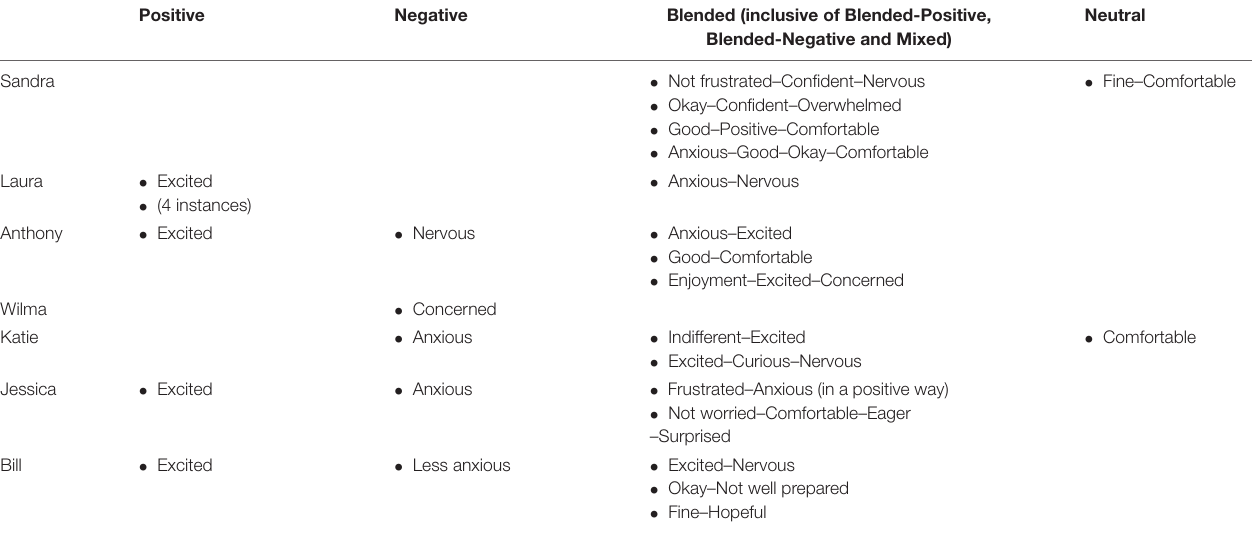
TABLE 3 | Categorization of teachers’ emotions by type from the pre-coaching